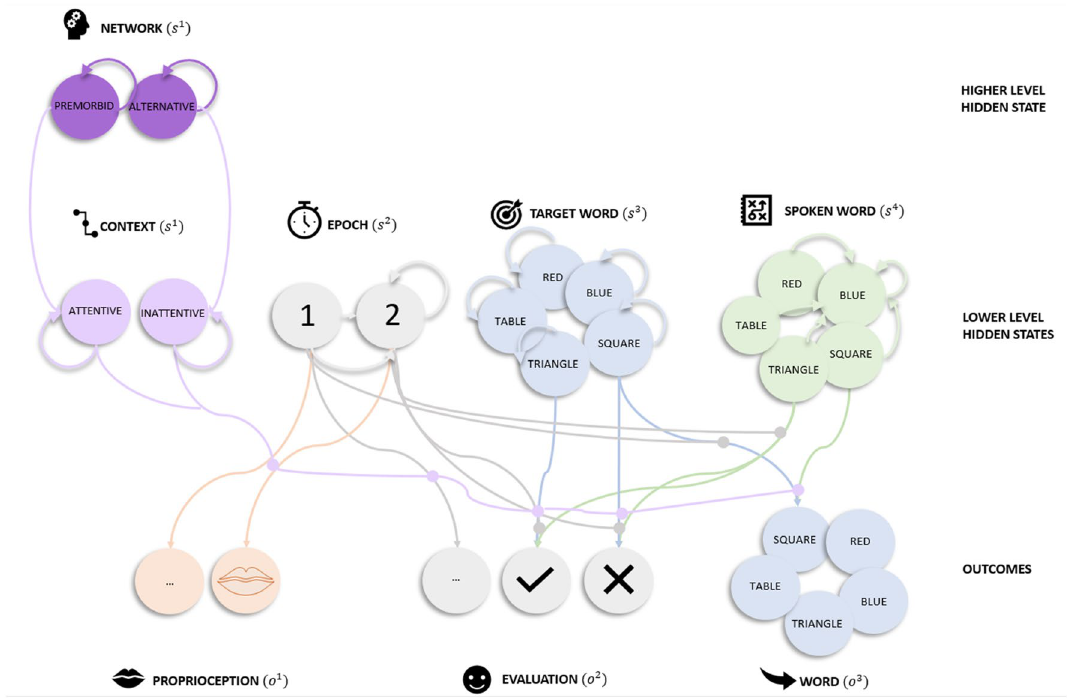
Figure 1. Generative Model. Graphical representation of the generative model for word repetition. The model comprises two levels. There is one higher-level state factor (Network), four lower-level state factors (Epoch, Target Word, Spoken Word, and Context) and three outcome modalities (Proprioception, Evaluation and Word). Network (2 states) at the higher level specifies the system in play (premorbid or alternative). Epoch (2 states) indexes the phase of the trial. During the first epoch, the target word is heard. The second epoch involves repeating the word and concomitant evaluation. A positive evaluation is provided if the Word outcome matches the Target Word state, and a negative evaluation otherwise. The Target Word factor (5 states) lists the words the experimenter can ask the participant to repeat. The Spoken Word factor includes the words that the model can choose to say (5 states). The Context factor (2 states) specifies whether the subject is in an attentive or inattentive state. Lines from states to outcomes represent the likelihood mappings and lines mapping states within a factor represent allowable state transitions. The lines represent plausible connections, and their absence reflects implausible connections. To avoid visual clutter, only a few likelihoods and transition probabilities are shown, but they are consistent across the different state factors and outcome modalities. For example, the Word likelihood mapping from the Target Word state (square) to the Word outcome (square) is shown for Epoch 1, but similar mappings apply when mapping between the blue Target Word and blue Word outcome and between the triangle Target Word state and triangle Word outcome, etc. One (from a total of 5) example transition probability is highlighted for the Spoken Word state, i.e., the transition is always to blue, regardless of previously spoken word (red, table, triangle, square or blue). This transition represents the choice to say ‘blue’. Similar mappings are applied when choosing to say ‘triangle’. Actions then correspond to the selection of particular transition probabilities. The Context factor modulates the strengths of the likelihood mappings between the other factors and outcomes, depending on whether the model is in an attentive or inattentive